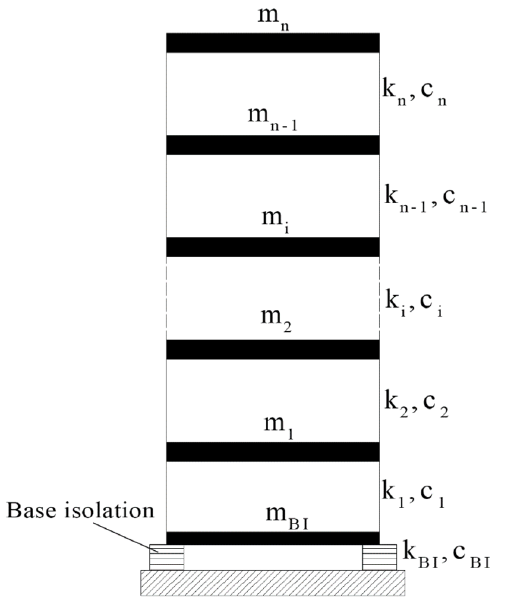
Figure 2. Base isolated shear building.